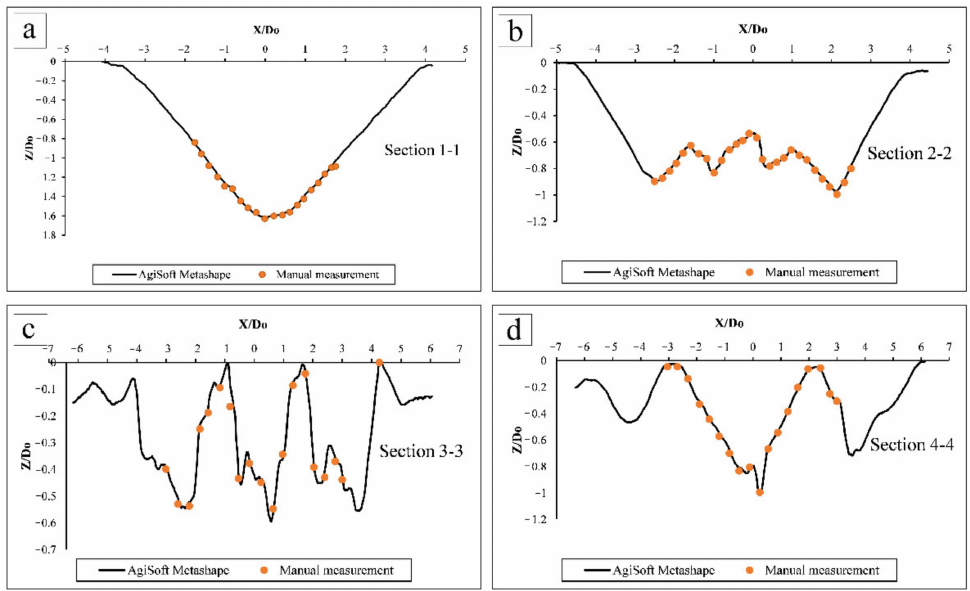
Figure 7. Output data from AgiSoft Metashape compared with the manually measured data at cross-sections (1-1) ( a ), (2-2) ( b ), (3-3) ( c ), and (4-4) ( d ) according to the cross-section plan.